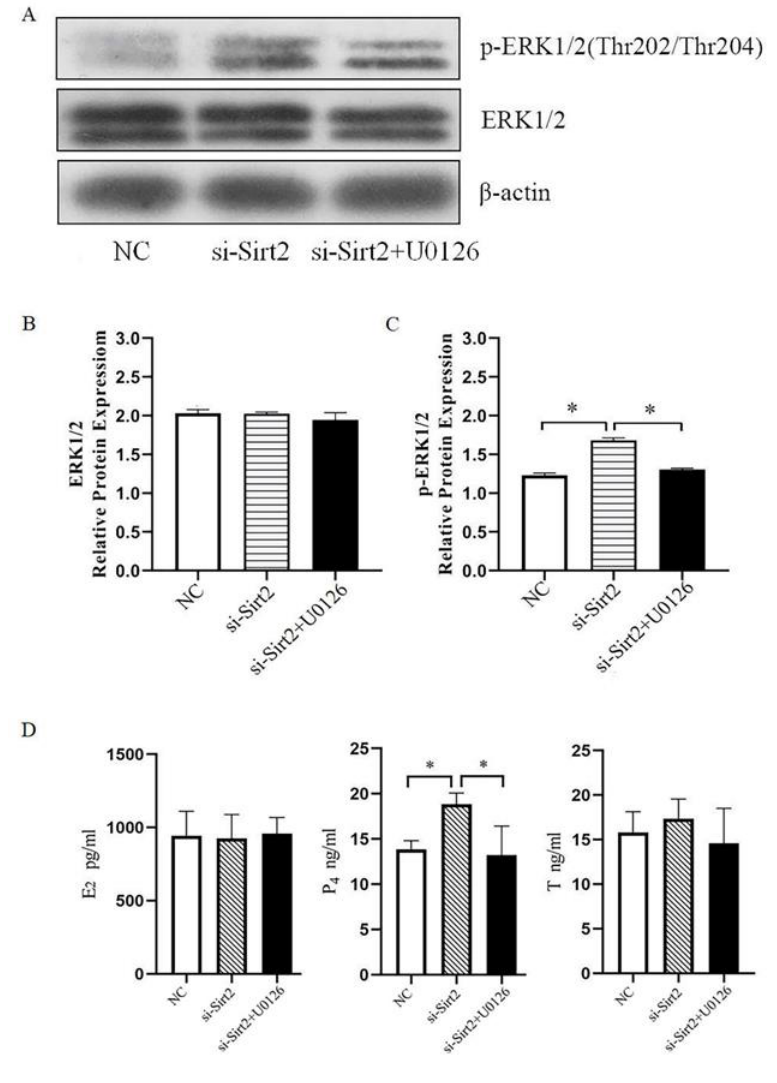
Figure 9. Sirt2 knockdown in granulosa cells affects steroid hormone secretion through ERK1/2. ( A ) Western blot representative images of p-ERK1/2 and ERK1/2 in different treatment groups. ( B ) ERK1/2 protein expression levels in different treatment groups. ( C ) p-ERK1/2 protein expression levels in different treatment groups. ( D ) The levels of E 2 , P 4 , and T secreted by granulosa cells in different treatment groups were detected by ELISA. The graph shows the mean ± SEM of the results obtained in three independent experiments. *, significant difference ( p < 0.05).